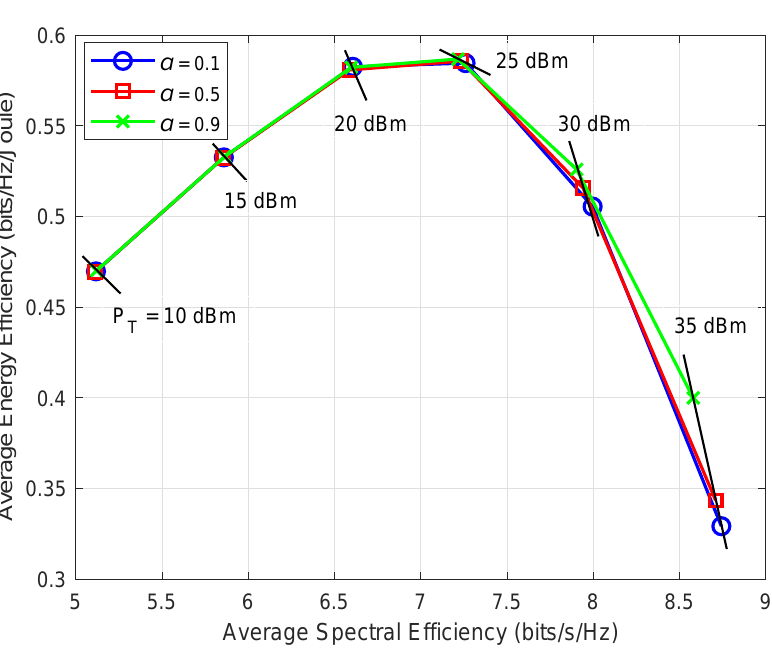
Figure 3. Average EE-SE trade-offs with different a under different transmit power budgets P T .